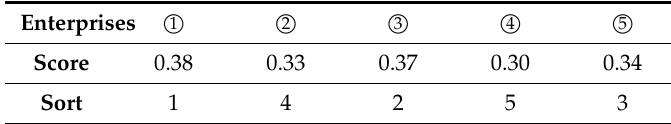
Table 10. Power generation enterprises energy-saving emission reduction sustainable operation e ffi ciency score results.